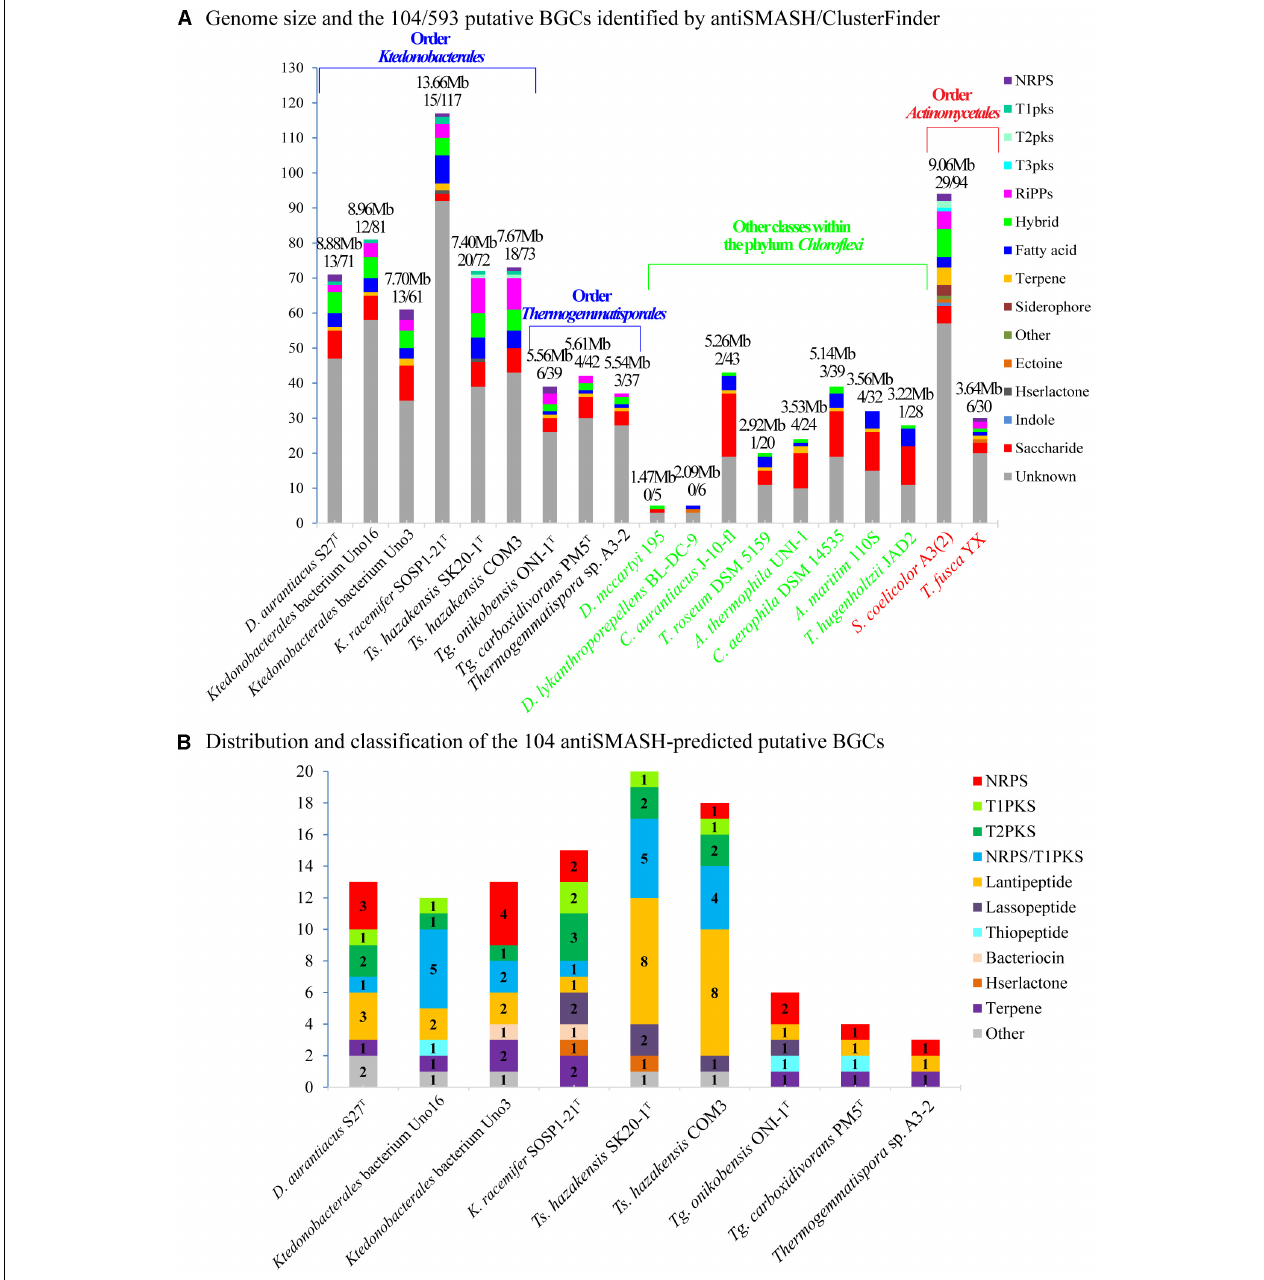
FIGURE 5 | Composition and distribution of the ClusterFinder-identified putative BGCs (A) and antiSMASH-identified putative BGCs (B) in the nine Ktedonobacteria genomes. Strains Dehalococcoides mccartyi 195 and Dehalogenimonas lykanthroporepellens BL-DC-9 (class Dehalococcoides ), Chloroflexus aurantiacus J-10-f1 (class Chloroflexi ), Thermomicrobium roseum DSM 5159 (class Thermomicrobia ), Anaerolinea thermophila UNI-1 (class Anaerolineae ), Caldilinea aerophila DSM 14535 (class Caldilineae ), Ardenticatena maritima strain 110S (class Ardenticatenia ), and Thermoflexus hugenholtzii JAD2 (class Thermoflexia ) of the phylum Chloroflexi and strains Streptomyces coelicolor A3(2) and Thermobifida fusca YX within order Actinomycetales , phylum Actinobacteria were used as reference strains for comparison.